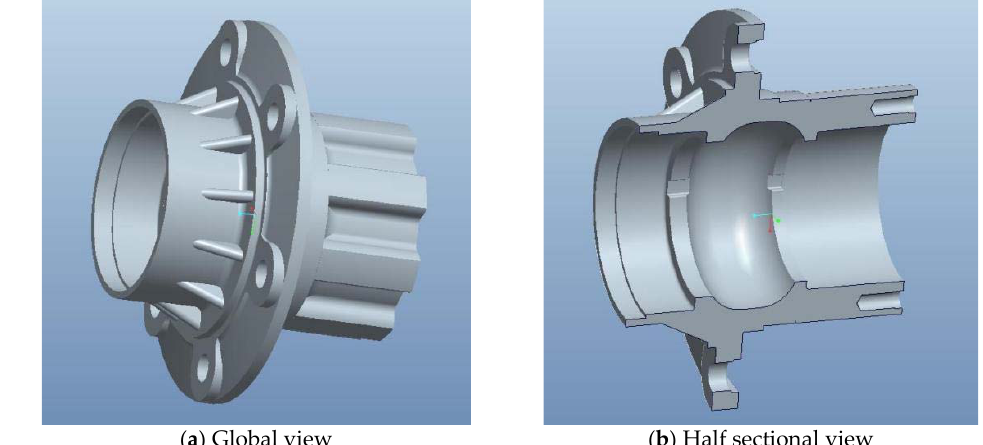
Figure 3. 3D model of the ZS061750 ‐ 152101 wheel hub.